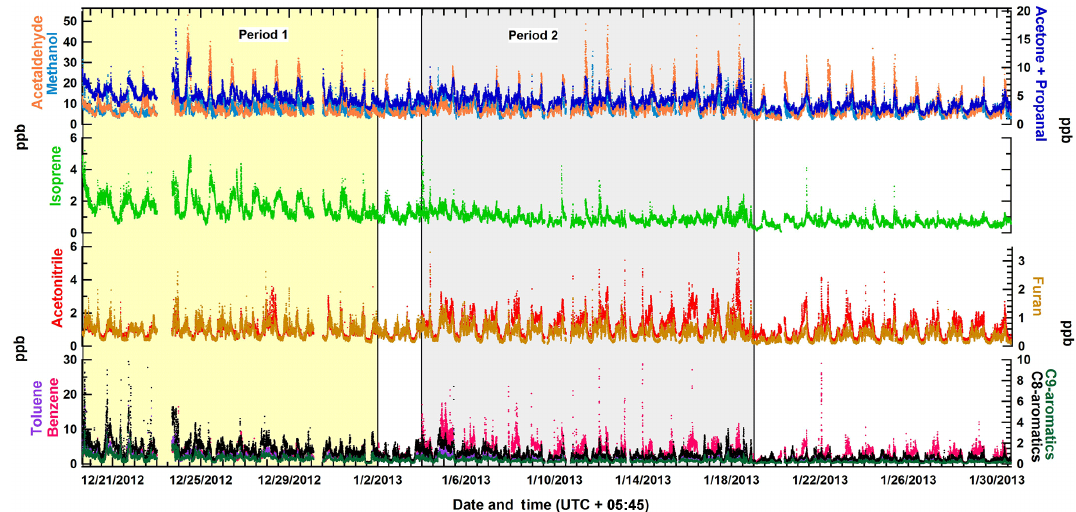
Figure 4. Time series of 1min time resolution data for the mixing ratios of methanol, acetaldehyde and the sum of acetone and propanal (top panel); isoprene (second panel from top); acetonitrile and furan (second panel from bottom); and benzene, toluene, the sum of C8-aromatics (xylene isomers and ethyl benzene) and the sum of C9-aromatics (isomers of trimethyl benzenes and propyl benzenes) (bottom panel) during the SusKat-ABC